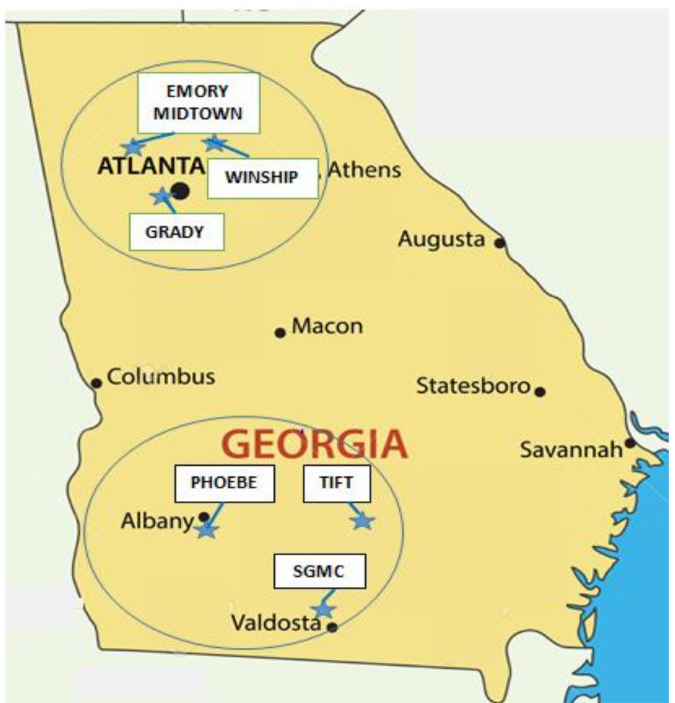
Figure 1. Cancer Centers in metropolitan Atlanta and Southwest Georgia assisting in study recruitment of breast cancer survivors. SGMC = South Georgia Medical